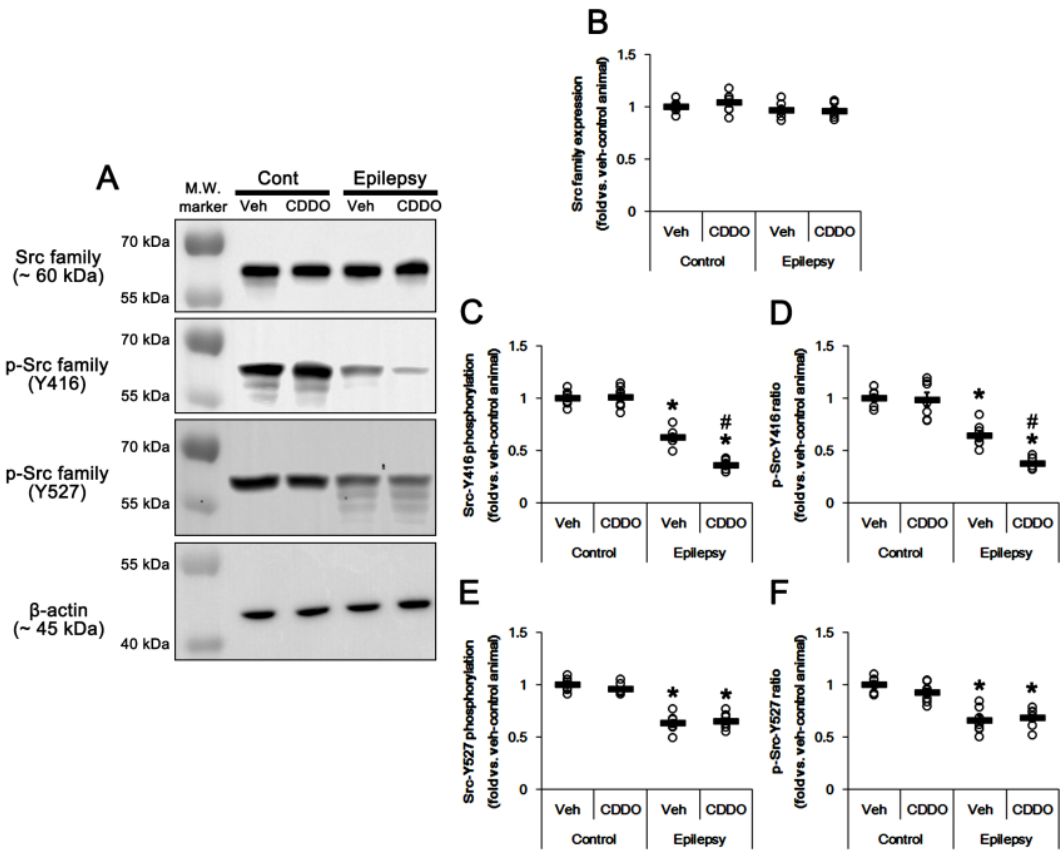
Figure 6. Effects of CDDO-Me on Src and p-Src levels in the CA1 region of control and epileptic rats. As compared to control animals (Cont), Src-Y416 and Y527 phosphorylation was reduced in the CA1 region of epileptic rats without altering its expression level. CDDO-Me treatment decreased Src-Y416, but not Y527, phosphorylation in epileptic rats. ( A ) Representative Western blot for Src and p-Src in the CA1 regions. ( B–F ) Quantitative values (mean ± SEM) of protein, phosphorylation and phosphorylation ratio concerning Src ( n = 7, respectively). Open circles indicate each value. Horizontal bars indicate the mean value. Significant differences are * ,# p < 0.05 vs. control animals and vehicle-treated animals.